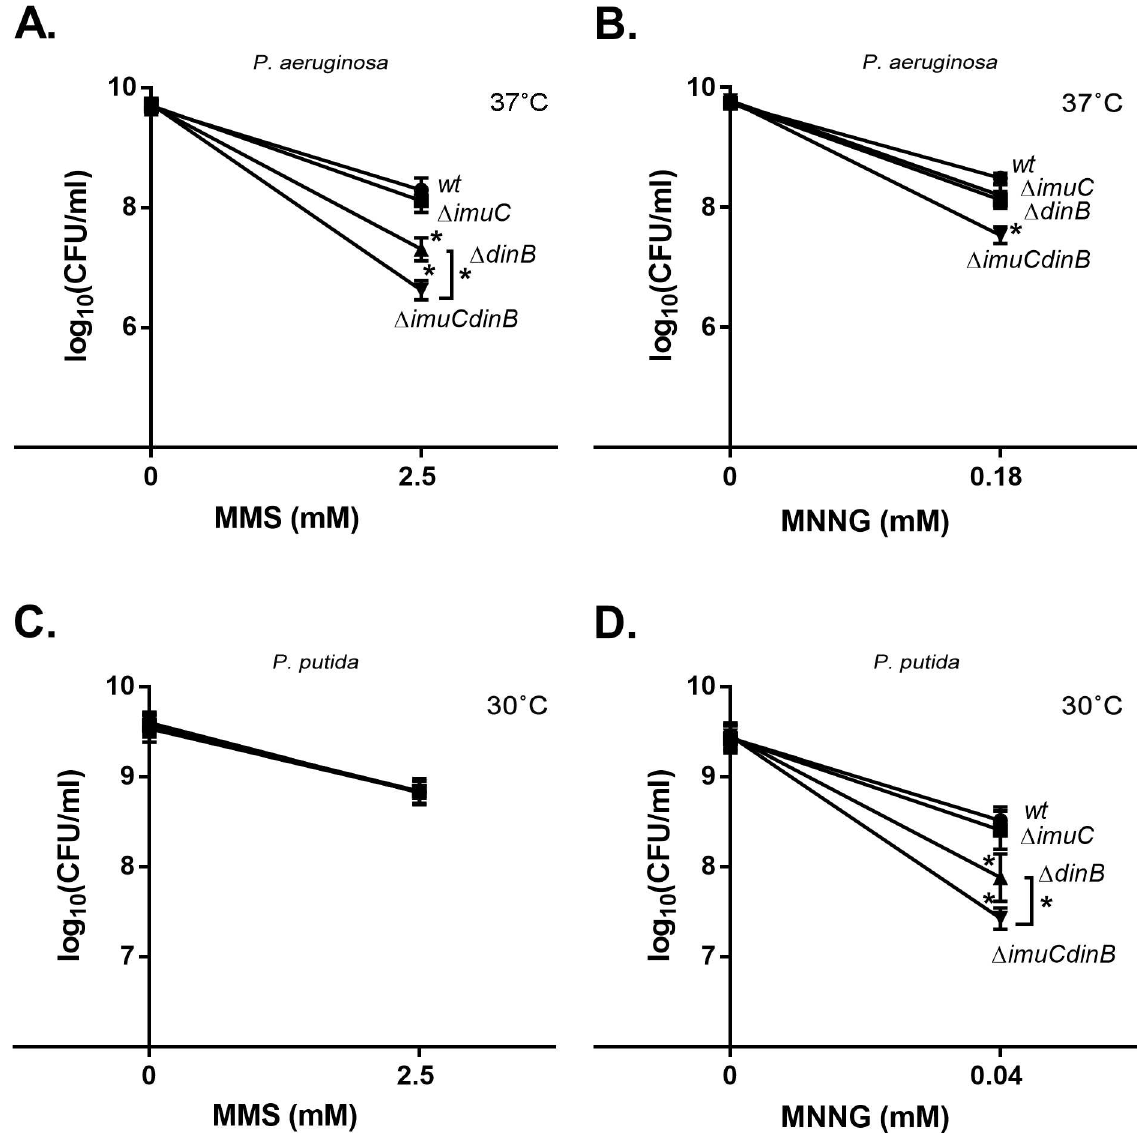
Fig 1. Sensitivity of P . aeruginosa and P . putida wild-type and their TLS polymerase-deficient derivatives to MMS and MNNG. Sensitivity was estimated by spotting 10-fold dilutions of overnightcultures of P . aeruginosa (A, B) and P . putida (C, D) onto LB plates containingMMS (A, C) or MNNG (B, D). P . aeruginosa was incubatedat 37˚C for 24 h (A, B). P . putida was incubatedat 30˚C on MMS-containing plates for 48 h (C) and on MNNG for 24 h (D). Data represents the mean ( ± 95%CI)values. ( ● ) wild-type; ( ■ ) Δ imuC ;( ▲ ) Δ dinB ;( ▼ ) Δ imuCdinB . Asterisks indicatestatistically significantdifference (maximum value P < 0.05; two-way ANOVA followedby Tukey’s multiple comparison post hoc test) in sensitivity betweenthe mutant and the wild-typestrain or betweenthe Δ dinB and the Δ imuCdinB (A,